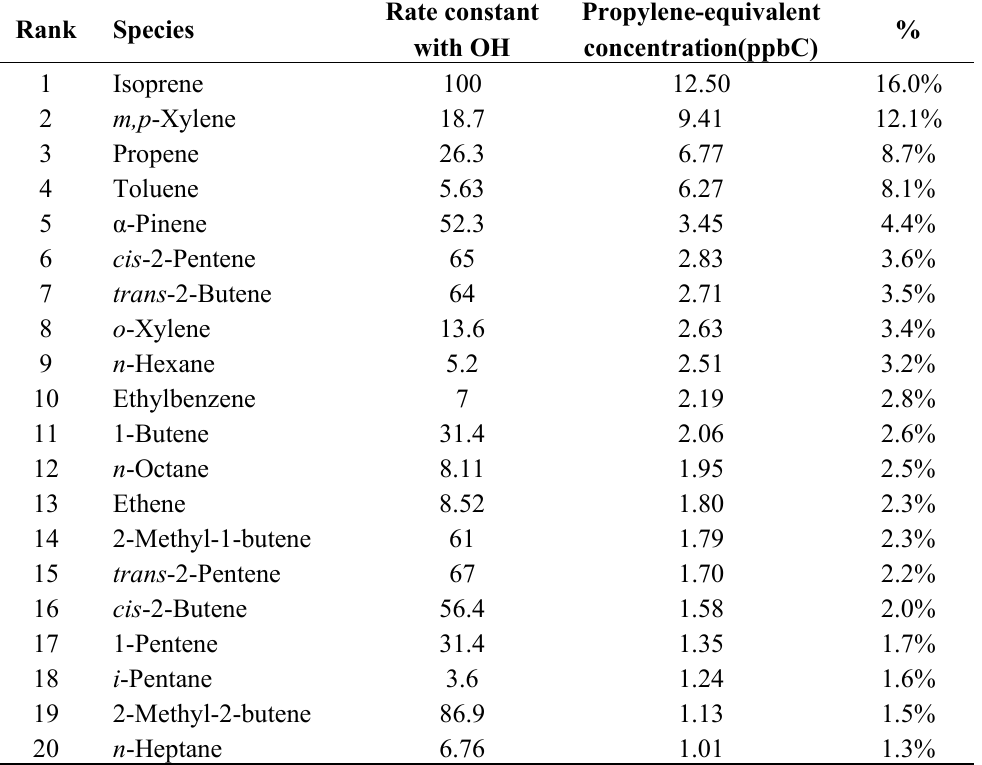
Table 3. The top 20 NMHCs ranked according to propylene-equivalent concentration. Rank Species